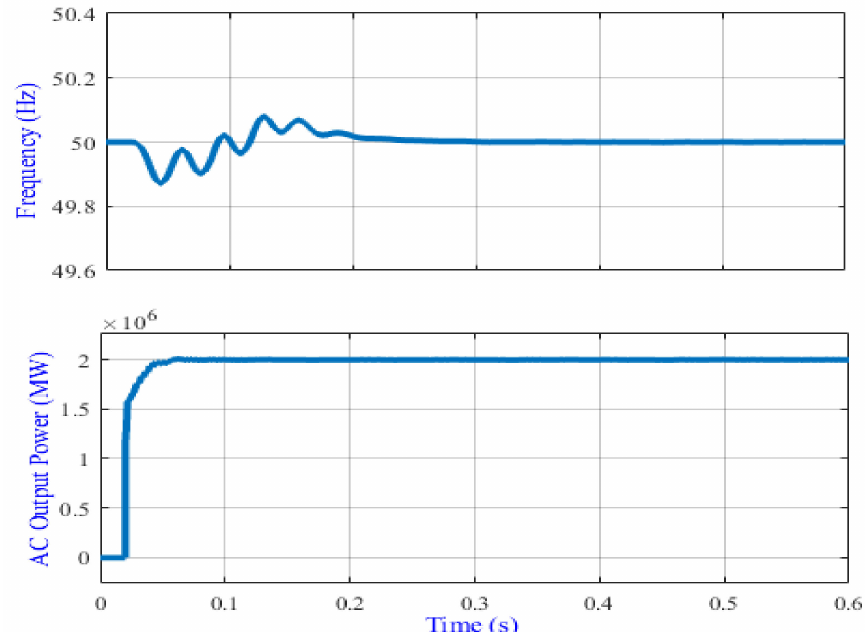
Figure 15. Active power control behavior during normal